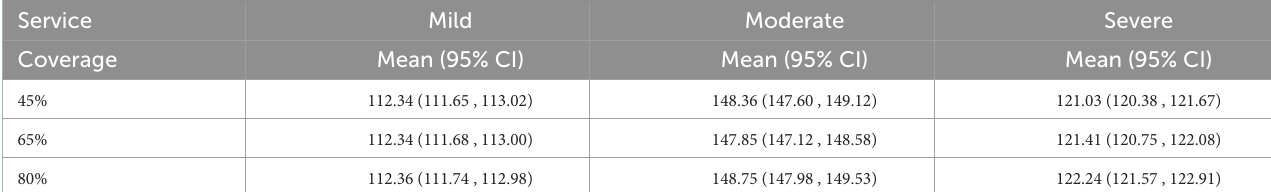
TABLE 2 Average depression prevalence by severity and service